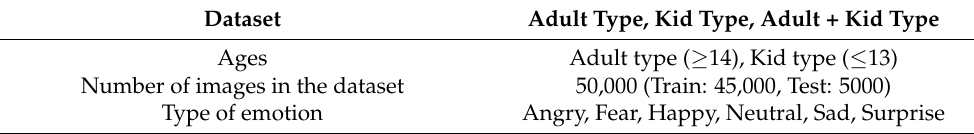
Table 1. Experimental variables.